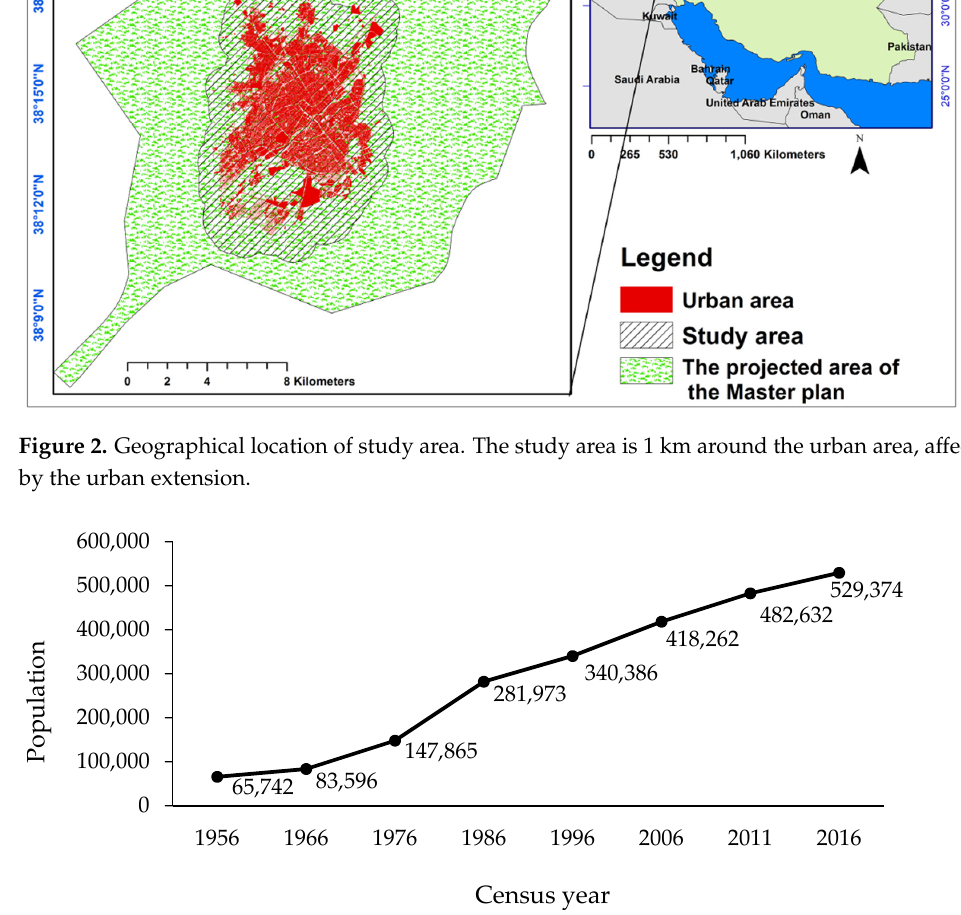
Figure 3. Population of Ardabil city according to the national census [ 27 ] .